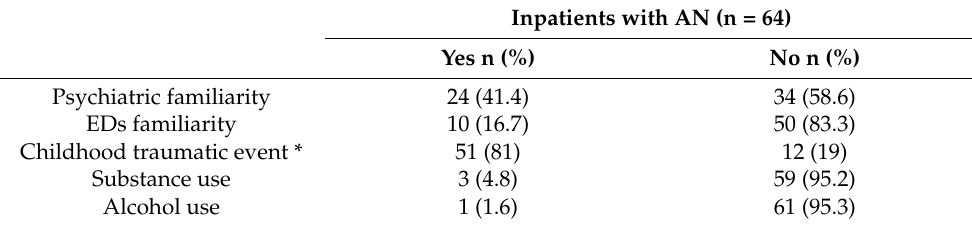
Table 2. Risk factors before AN onset in young patients with